Question: Write a descriptive caption for this figure.
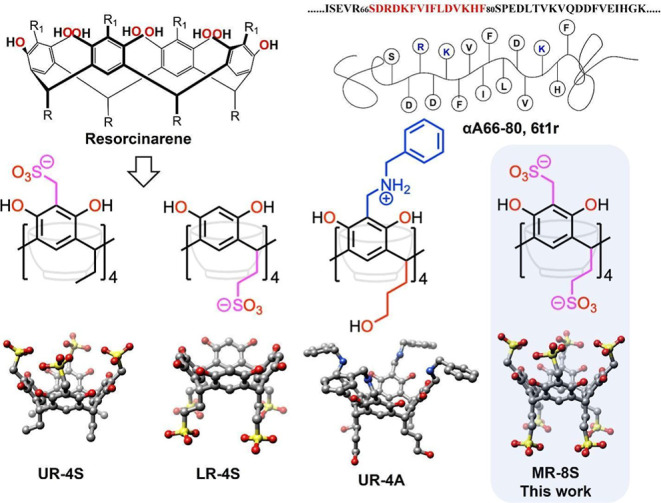
Answer: Structure of the αA66–80 Crystallin peptide chain and DFT-optimized geometries of functionalized polyionic macrocycles: upper-rim tetrasulfonated resorcinarene ( UR-4S ), lower-rim tetrasulfonated resorcinarene ( LR-4S ), upper-rim N -benzyl ammonium resorcinarene chloride ( UR-4A ), and mixed-rim octasulfonated resorcinarene ( MR-8S ). Macrocycle structures were optimized at the B3LYP /6–31G­(d,p) , level of theory. Atom color scheme: carbon, gray; nitrogen, blue; oxygen, red; sulfur, yellow; hydrogen atoms are omitted for clarity.